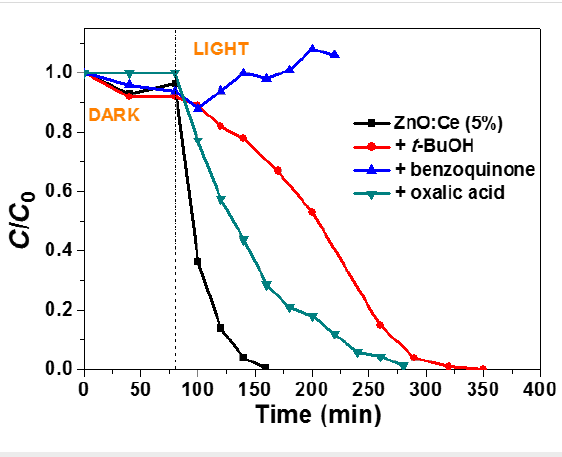
Figure 14: Influence of t -BuOH, benzoquinone and oxalic acid used as • OH, O 2• − and h + scavengers, respectively, on the photocalytic activity of the ZnO/Ce